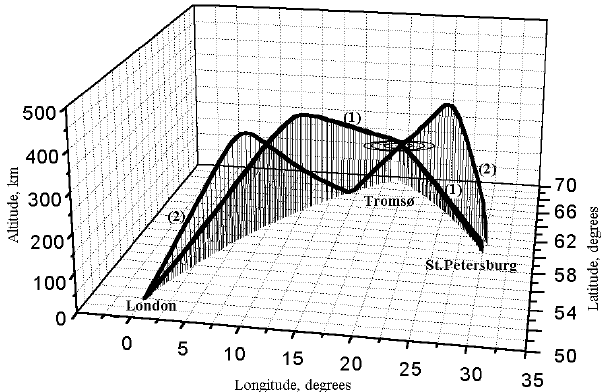
Fig. 6. Calculated values of Doppler frequency shift f d versus di- rection of plasma velocity for velocities in the range from 200 to 1000m/s on the London - Tromsø – St.Petersburg path. Calcula- tions are made for 9410kHz and an electron density in the scattering volume in the auroral E-region corresponding to f 0 E s =